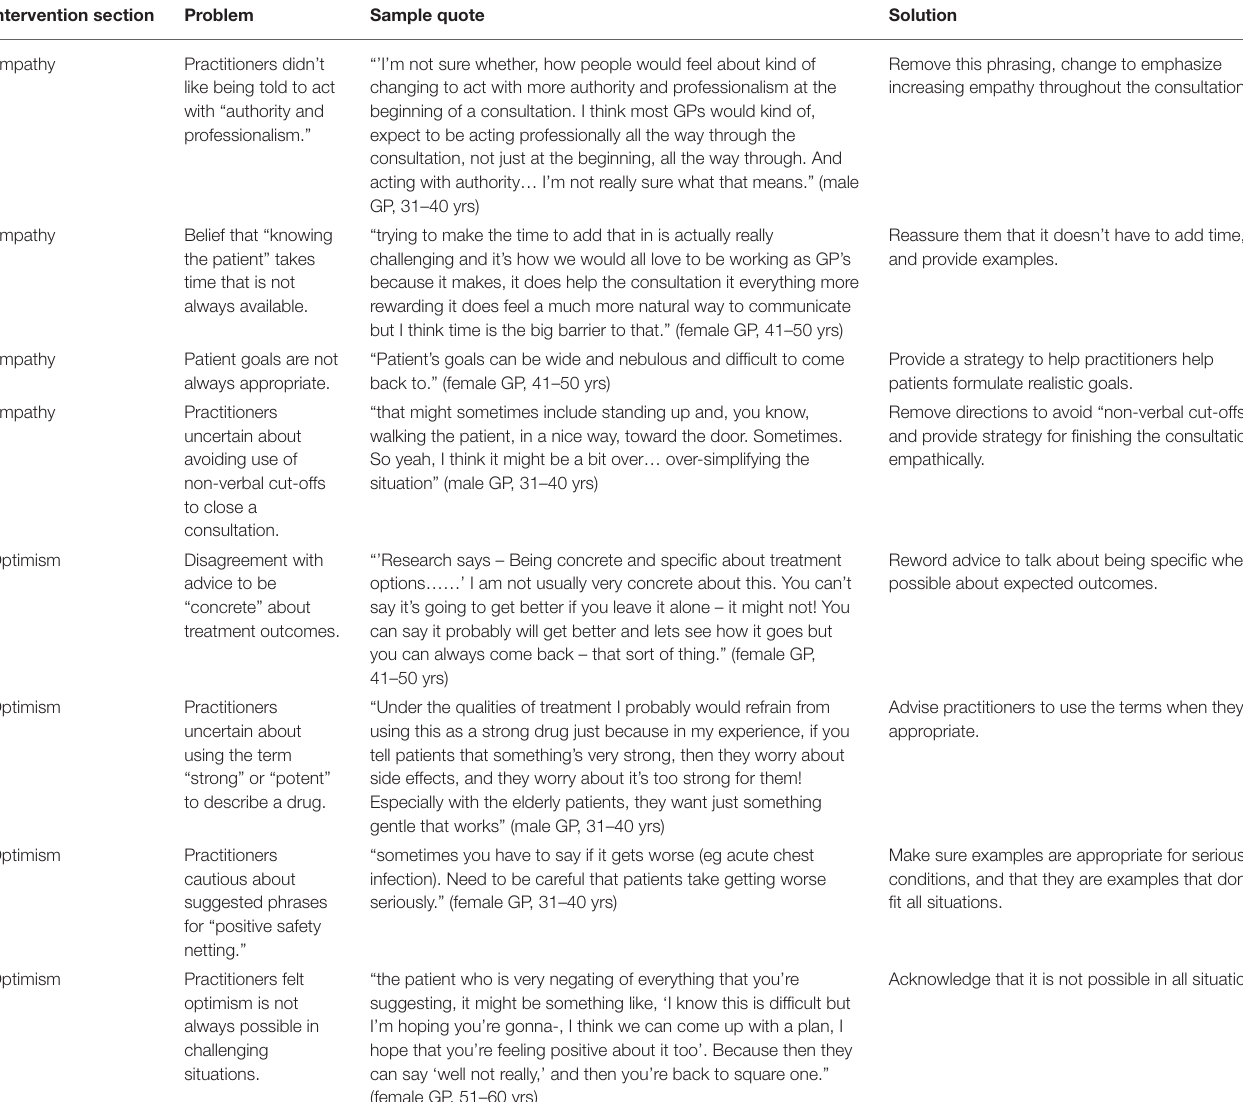
TABLE 7 | Illustrative examples of problems and solutions identified through “table of changes” analysis of think-aloud interviews on intervention components. Intervention